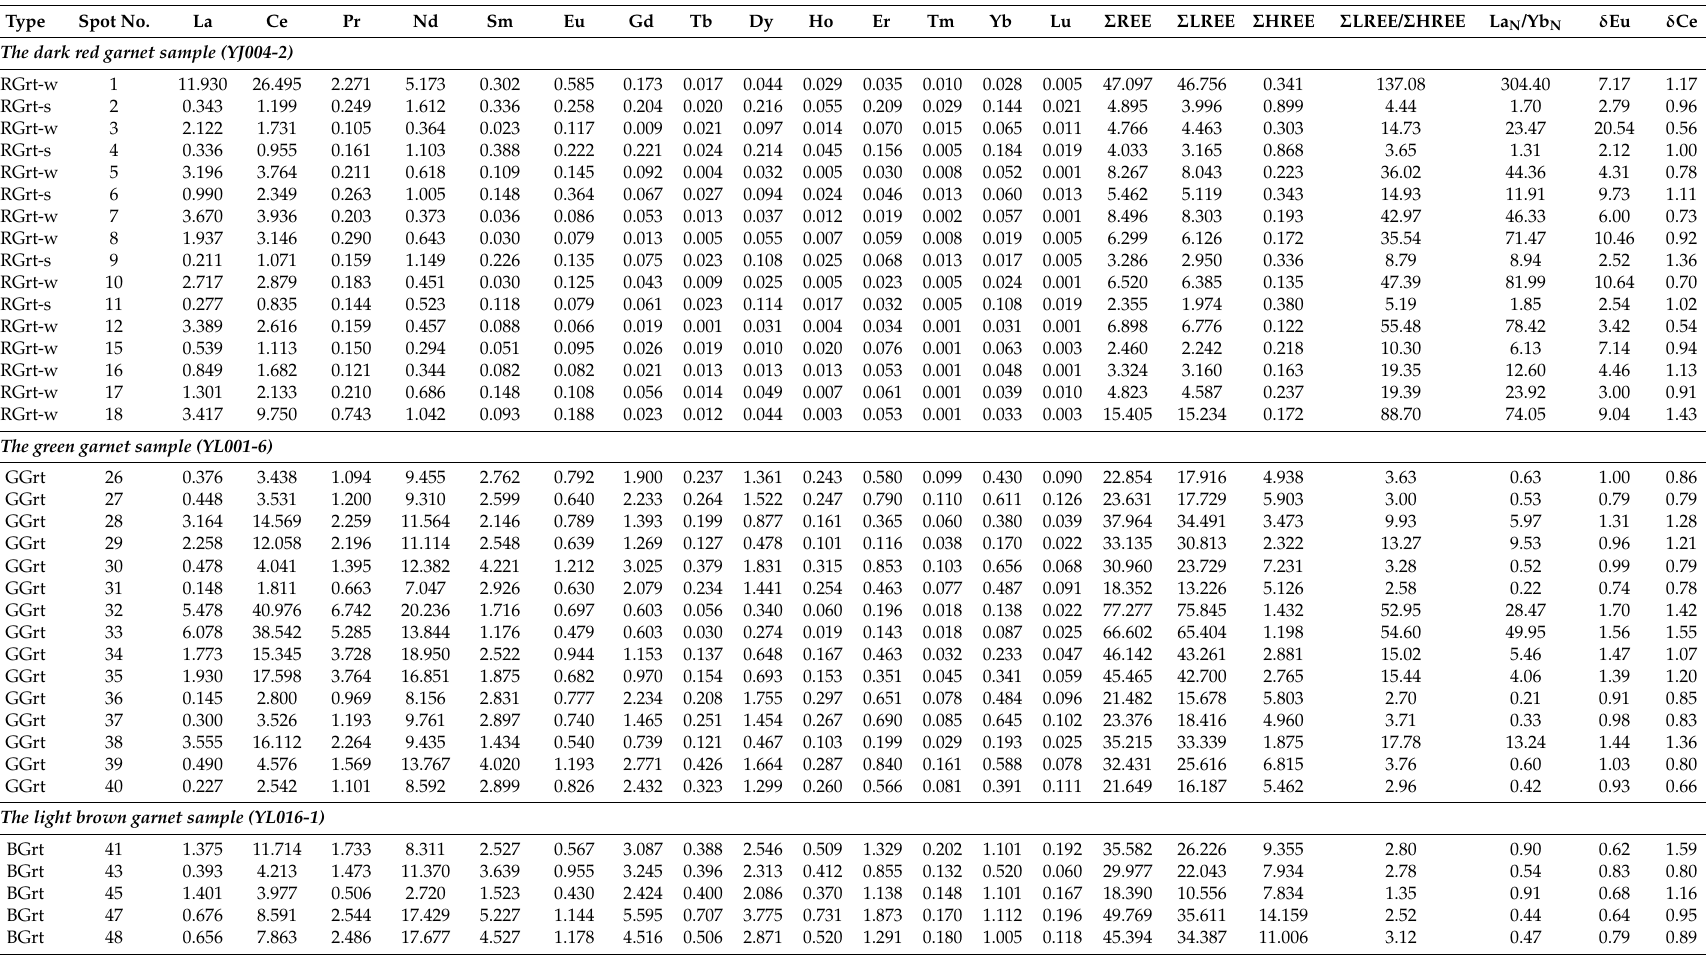
Table 2. Representative LA-ICP-MS rare earth elements data (ppm) of the Yongping